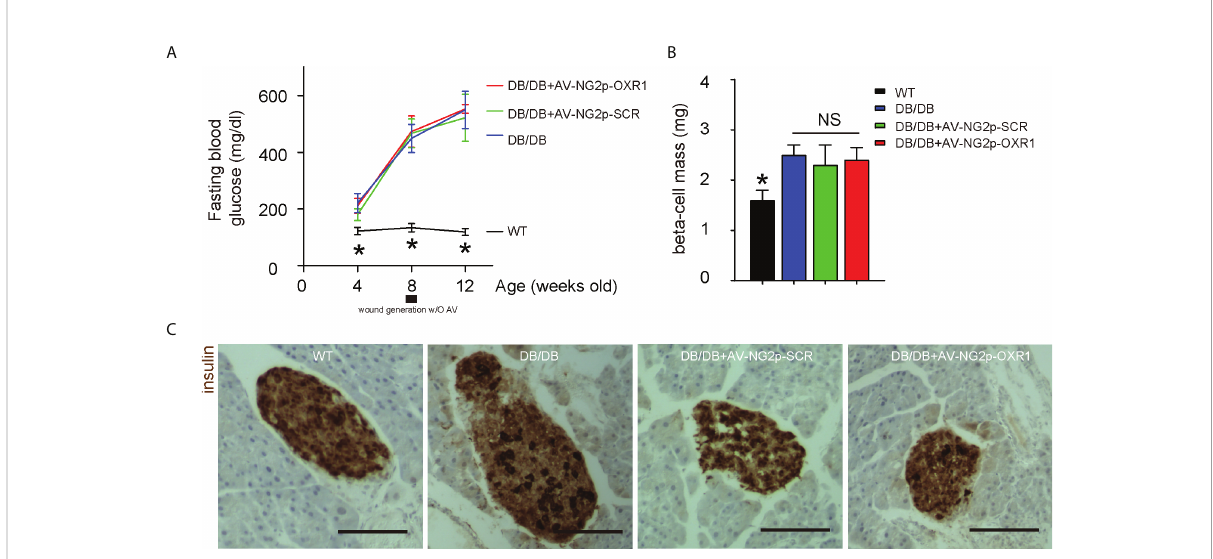
FIGURE 5 Gene therapy with AV-NG2p-OXR1 does not alter diabetic status in DB/DB mice. DB/DB mice received injection of control saline or control AV- NG2p-SCR or AV-NG2p-OXR1 at the wound site at 8 weeks old when the wound was generated. Another group of wild-type mice was used